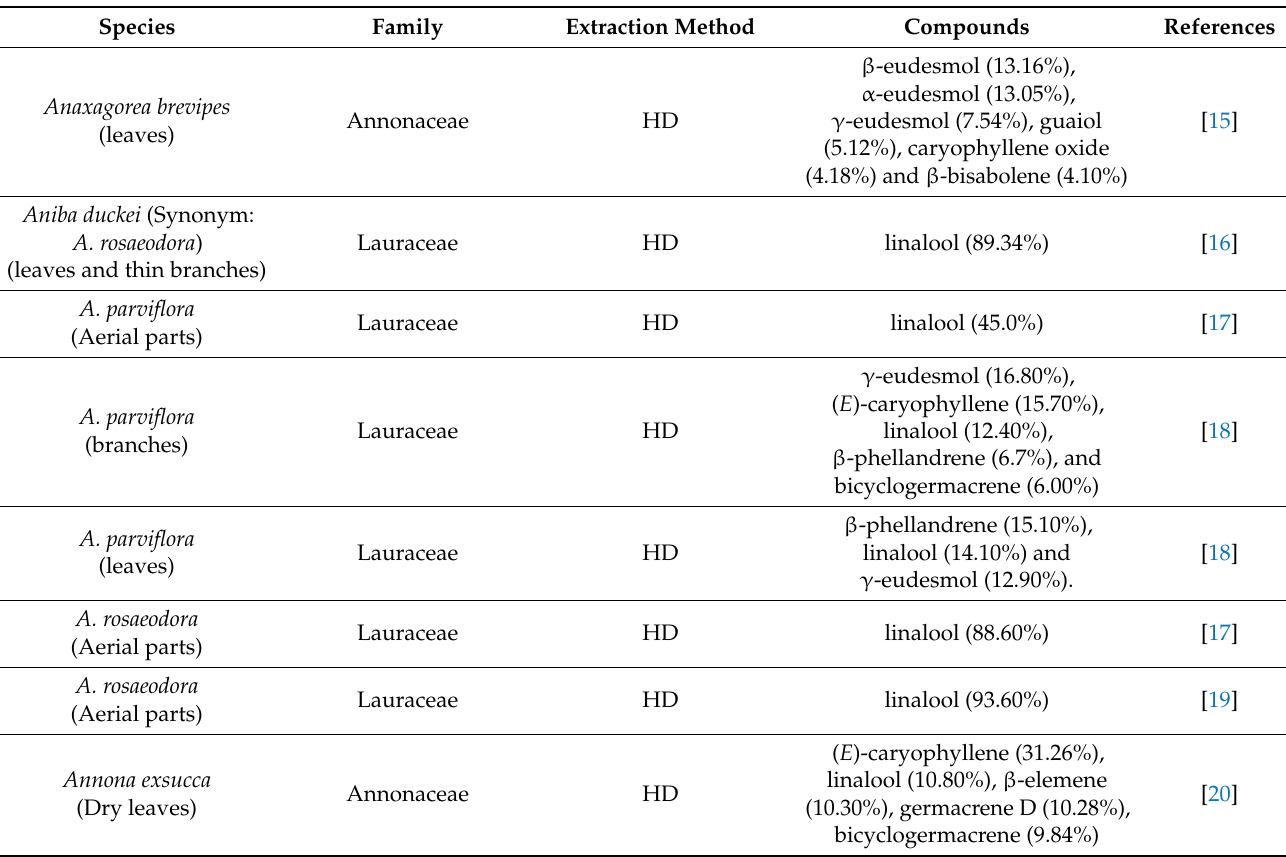
Table 1. Major chemical constituents ( ≥ 3.00%) found in the essential oils of the Amazon. Species Family Extraction Method